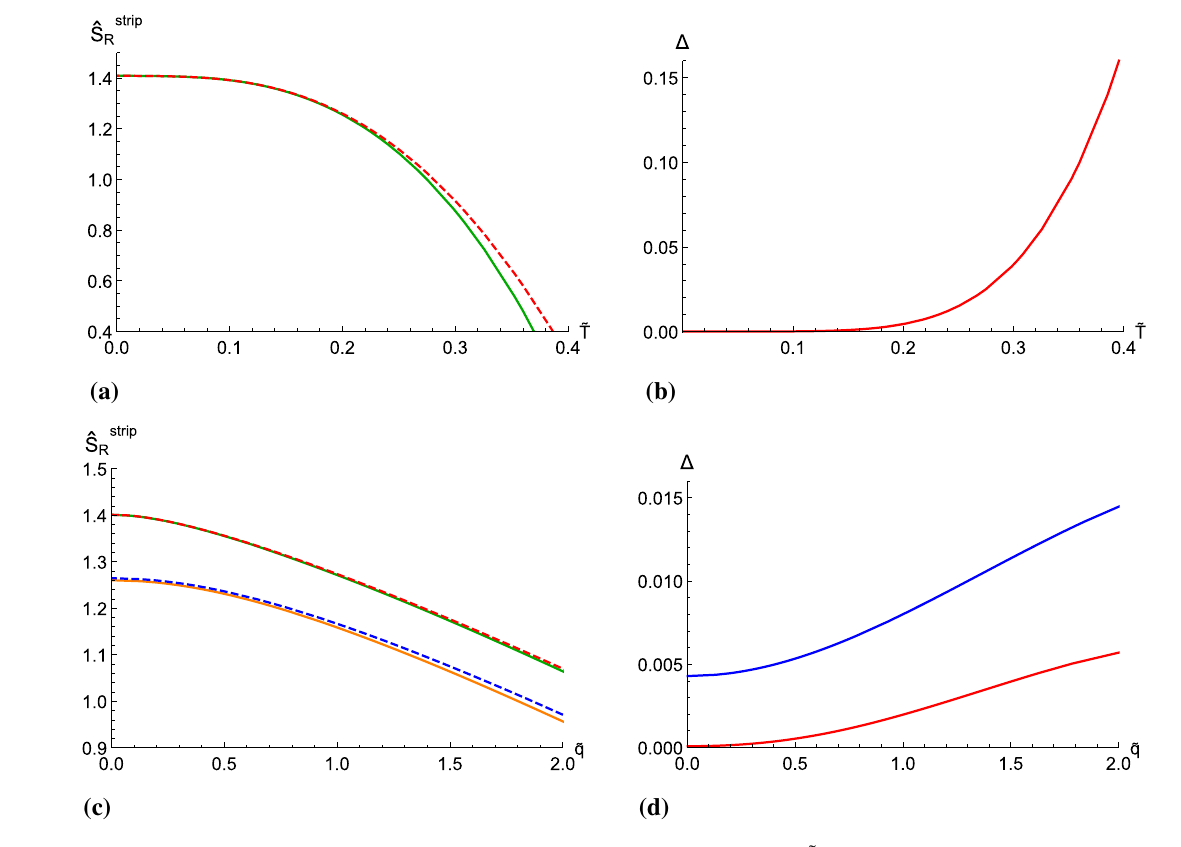
Fig. 4 Comparison of the numerical calculation(Dashed) and the ana- lytic one(Solid) for ˜ β = 0 . 2: a is for a fixed charge density ˜ q = 0 . 2 and b describes the difference, (cid:13) , between two results. As ˜ T grows, (cid:13) also increases. c Shows the case of a fixed temperature ˜ T = 0 . 1(Red-